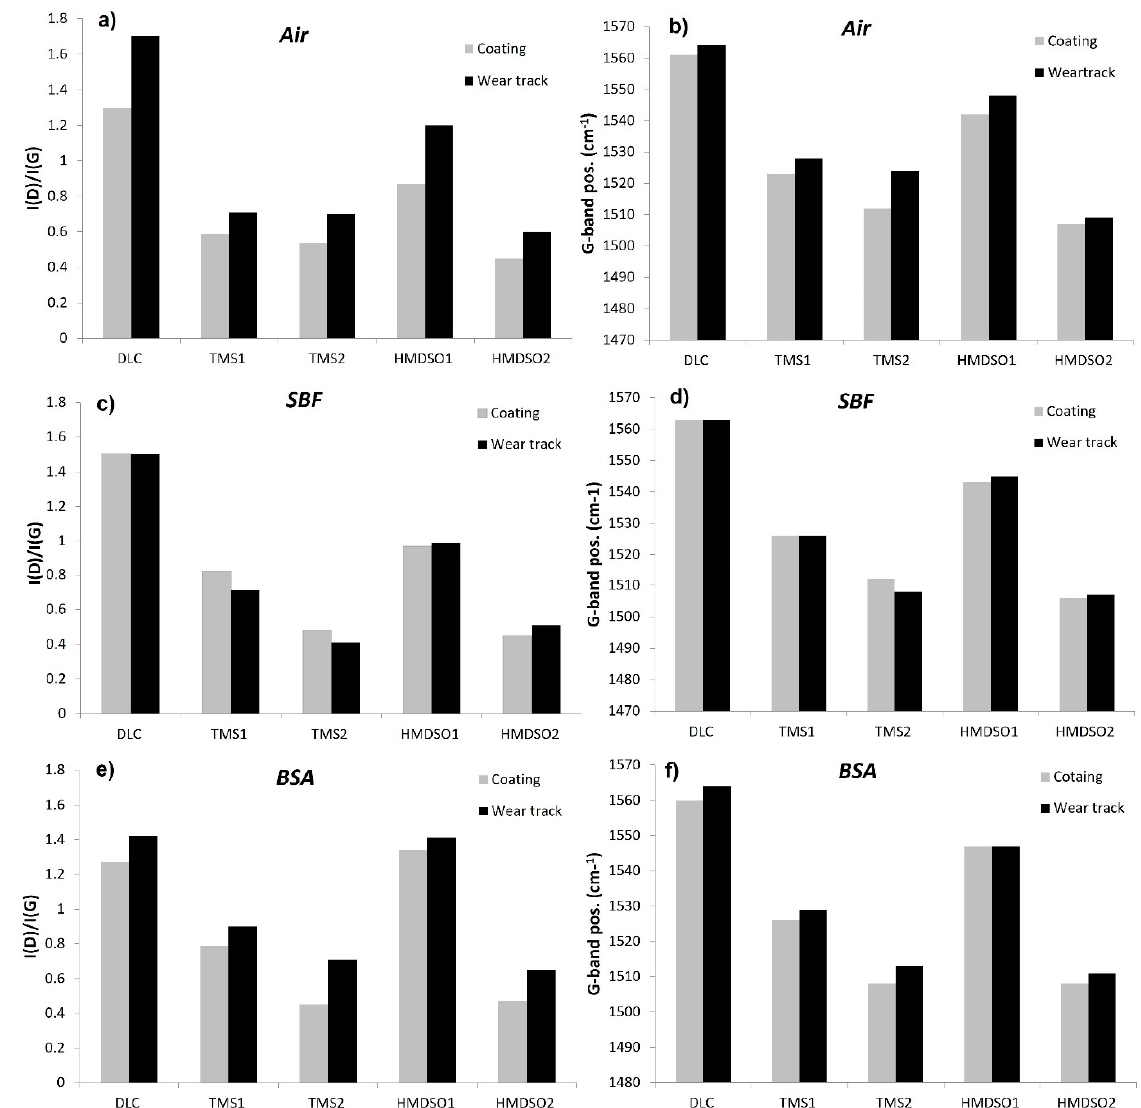
Figure 8. Changes in the ID/IG ratio ( left column ) and G-band position ( right column ) of the as-deposited coatings before and after the tribological tests in ( a , b ) air, ( c , d ) SBF, and ( e , f ) BSA envi- ronment.